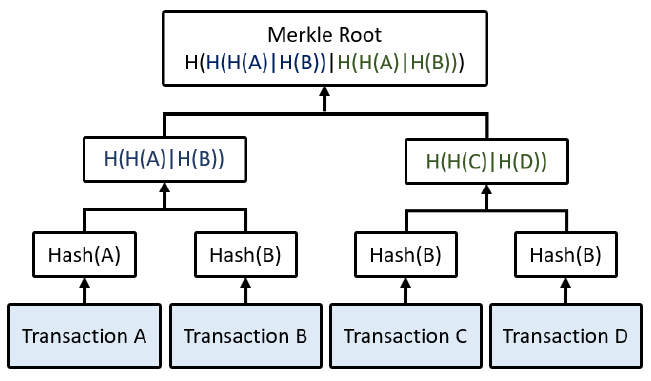
Figure 3. Merkle tree structure.